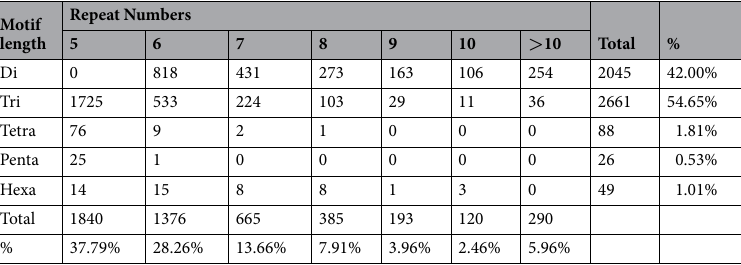
Table 4. Distribution and frequency of EST-SSRs identified in Solanum trilobatum